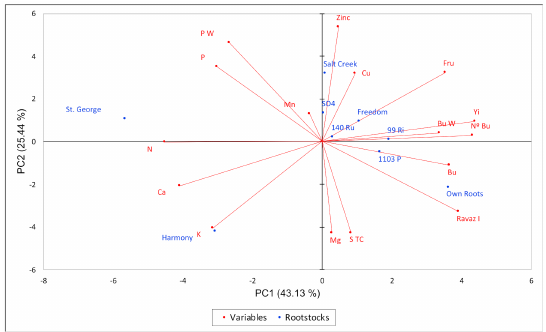
Figure 1. Principal component analysis (PCA) performed with yield, vigor, and nutritional variables obtained from Syrah grapevines grown ungrafted and grafted onto 1103 Paulsen, 140 Ruggeri, 99 Richter, Freedom, Harmony, Salt Creek, SO4 (Selection Oppenheim 4), and St. George (Rupestris du Lot). Footnote: The distribution of variables (red lines) and individual observations according to rootstocks (blue dots) on PC1 and PC2 are shown. Yi: yield, N ◦ Bu: number of bunches per plant, Bu W: bunch weight, Bu: budburst, Fru: fruitfulness, P W: pruning weight, Ravaz I: Ravaz index, S TC: scion trunk